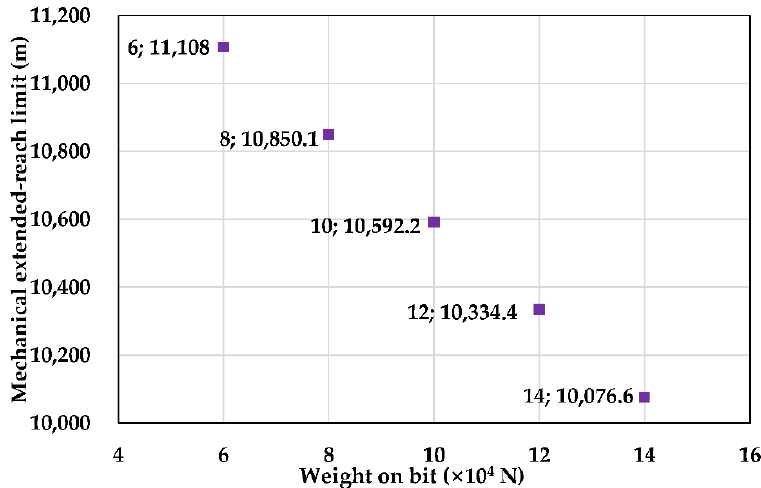
Table 9. Mechanical extended-reach limits with different weights on bit.